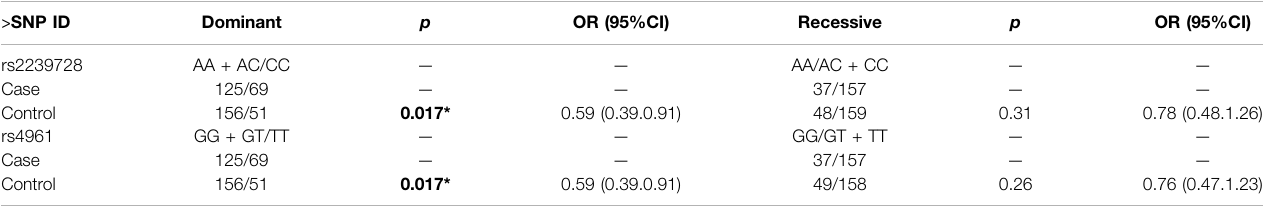
TABLE 8 | Association between ADD1 SNPs with EH risk in the Han population (based on logistical tests). —